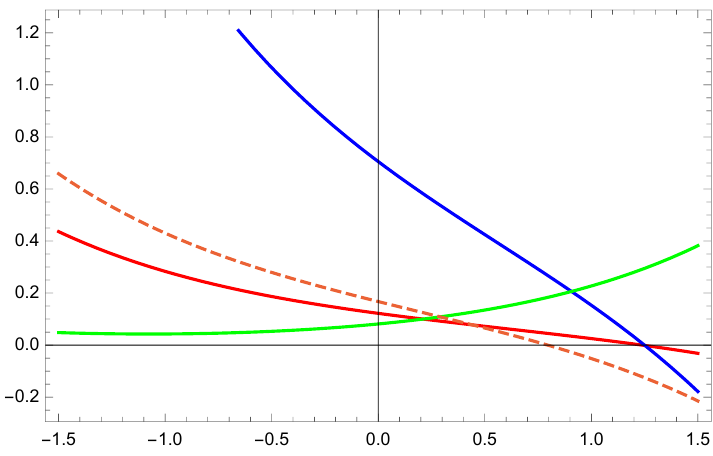
Figure 4 . Plots of slices of the potentials for four di(cid:11)erent \generic" (cid:13)ux sets that illustrate the bound.